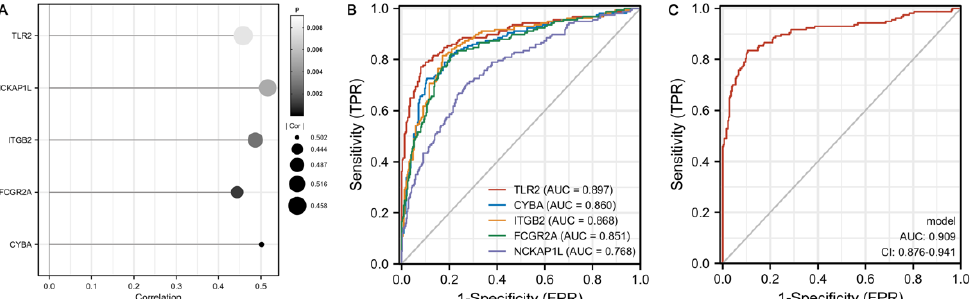
Figure 6. Correlation between hub genes and M2 macrophages and ROC analysis. ( A ) Lollipop diagram of the relationship between the five hub genes’ expression and M2 macrophages’ infiltration. ( B , C ) ROC curve analysis of the five hub genes and diagnostic model for predicting AD.